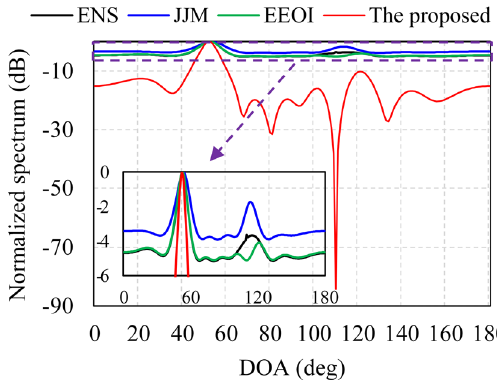
Fig. 3 Normalized spectrum when SIR